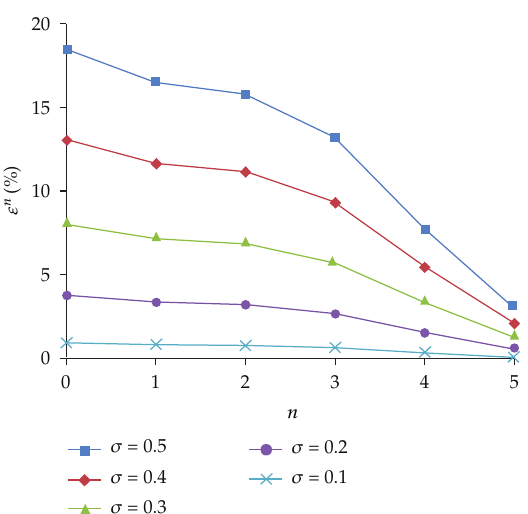
Figure 1: Squared error ratios of asymmetric characterizations of scalar-valued ODFs sampling from N (cid:3) 1 . 0 ,σ 2 (cid:4) in 2D.